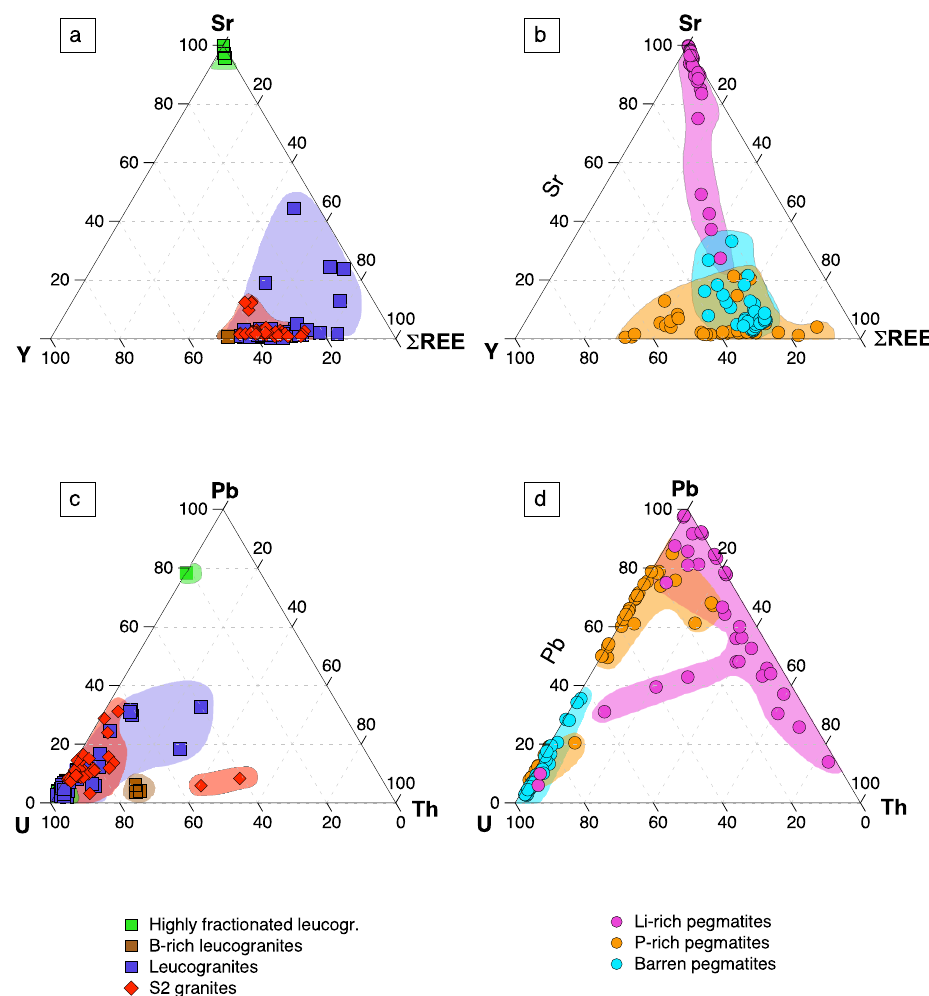
Figure 12. Triangular plots for apatite: ( a , b ) Sr-Y- Σ REE; and ( c , d ) Pb-U-Th, for the granitic and pegmatitic lithologies, respectively.